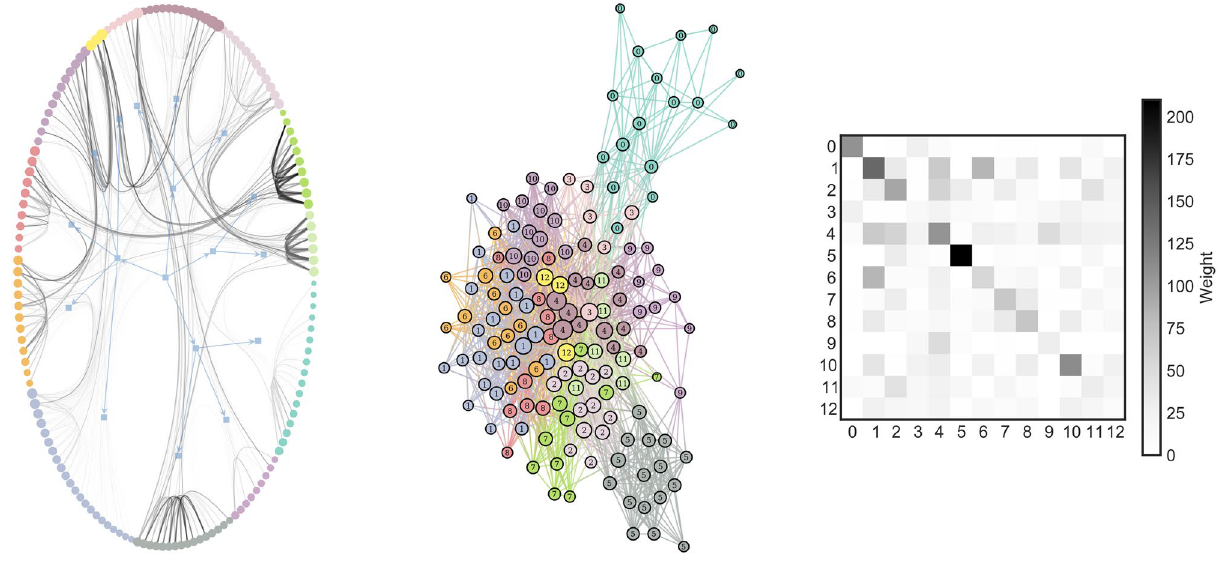
Figure 1. ENRON social network divided into 13 communities. On the left, is a hierarchical representation of the ENRON social network in which the agents are aligned on the periphery of the circle. This highlights, for example, that the 3 individuals from community 12 exchange massively with other communities. This representation is hierarchical as we can see higher-order groups in the form of blue blocks. In the middle and on the right, we have the most concrete level of the hierarchy represented as a single layer network and block matrix,